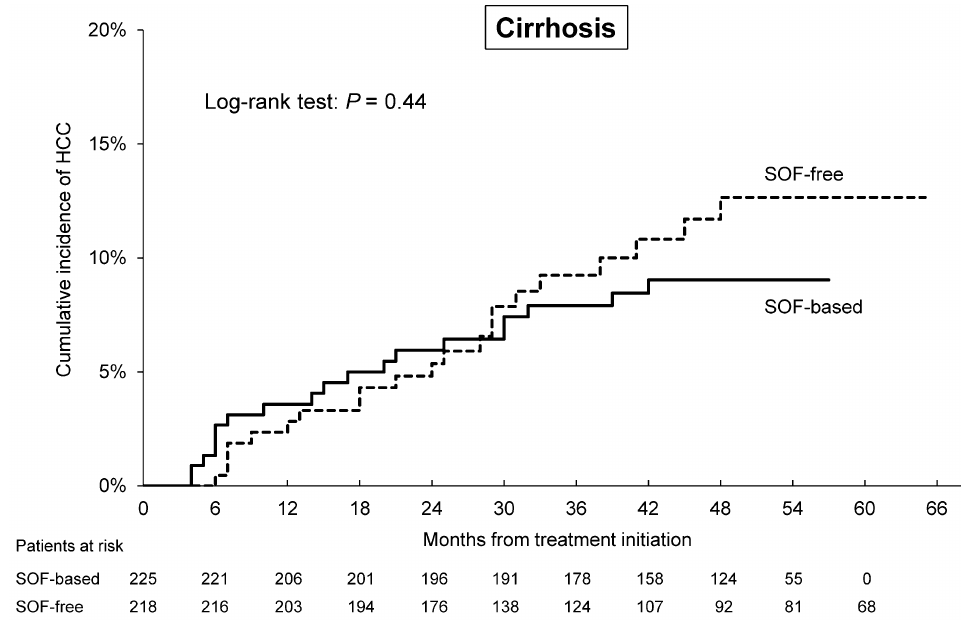
Figure 2. Cumulative rates of the development of hepatocellular carcinoma (HCC) in patients treated with DAA regimens with and without sofosbuvir (SOF). SOF-based: continuous line, SOF-free: dashed line.